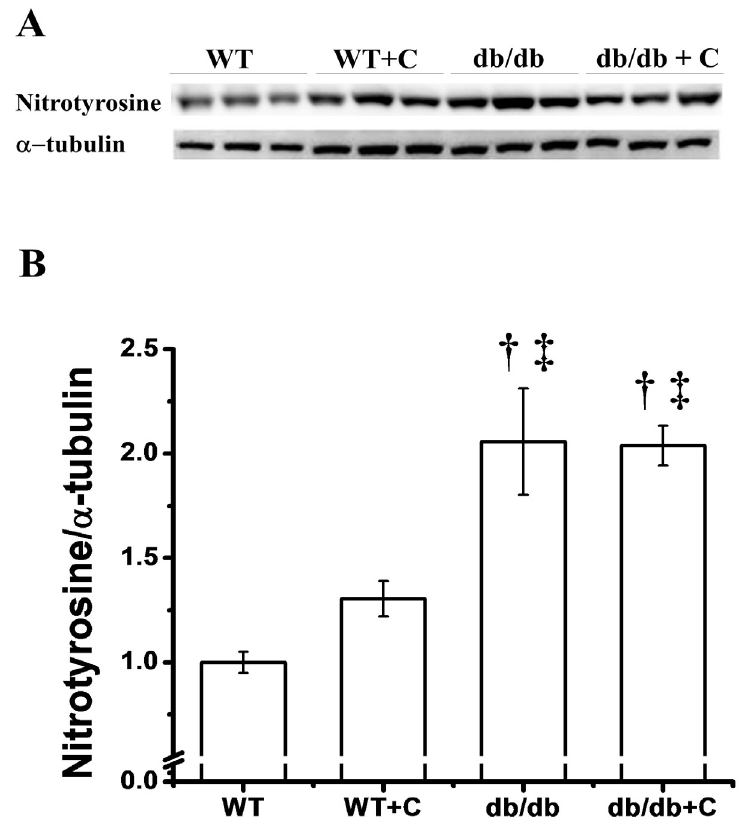
Figure 5. Effect of curcumin on the protein nitration (NT) content. ( A ) Representative western blot of the NT and of α -tubulin in liver. ( B ) Densitometry analysis of the NT/ α -tubulin